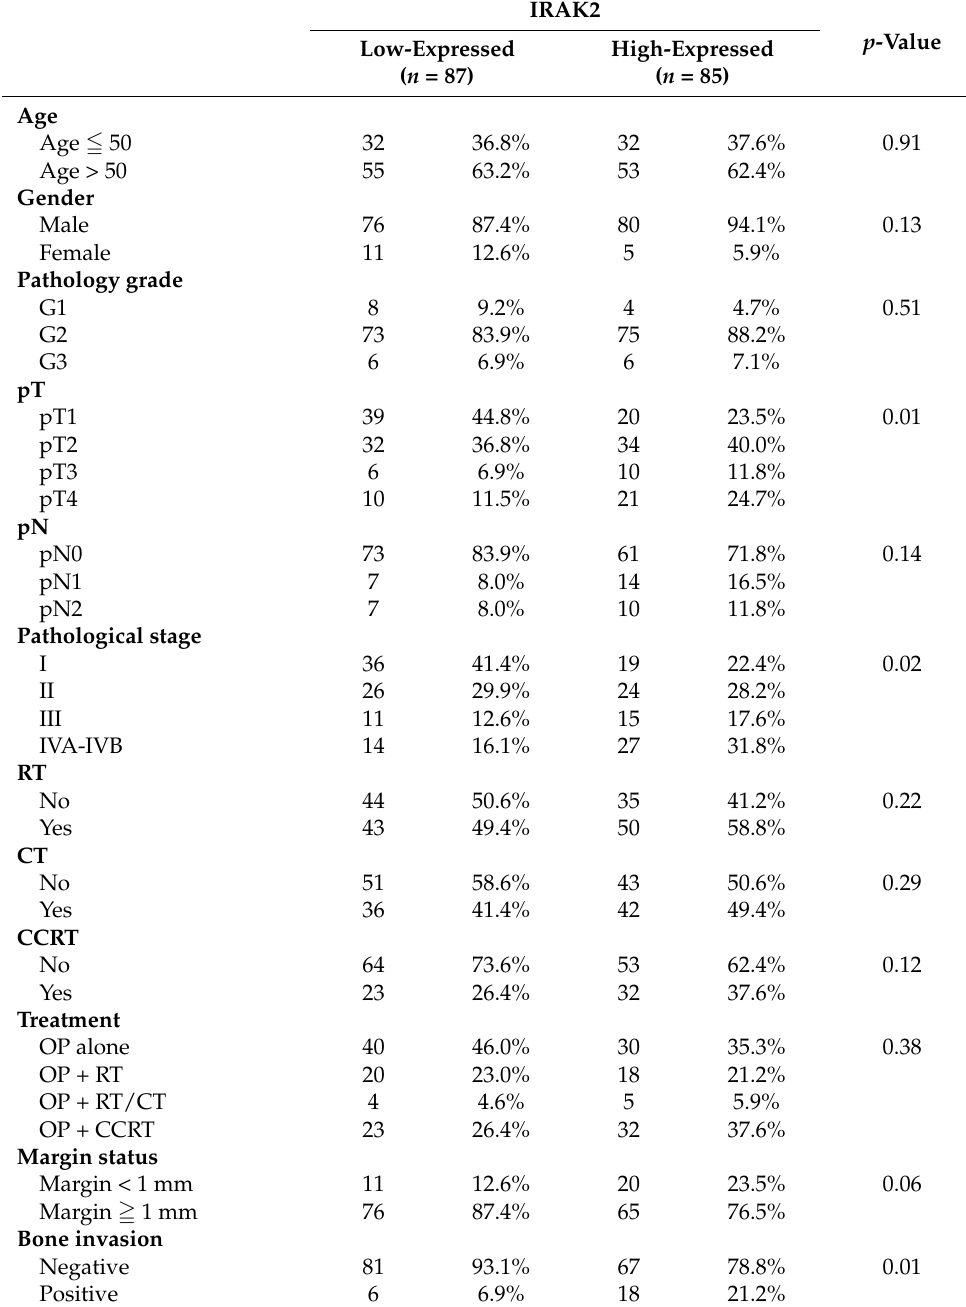
Table 2. Clinicopathological features of 172 oral cancer patients according to the expression level of